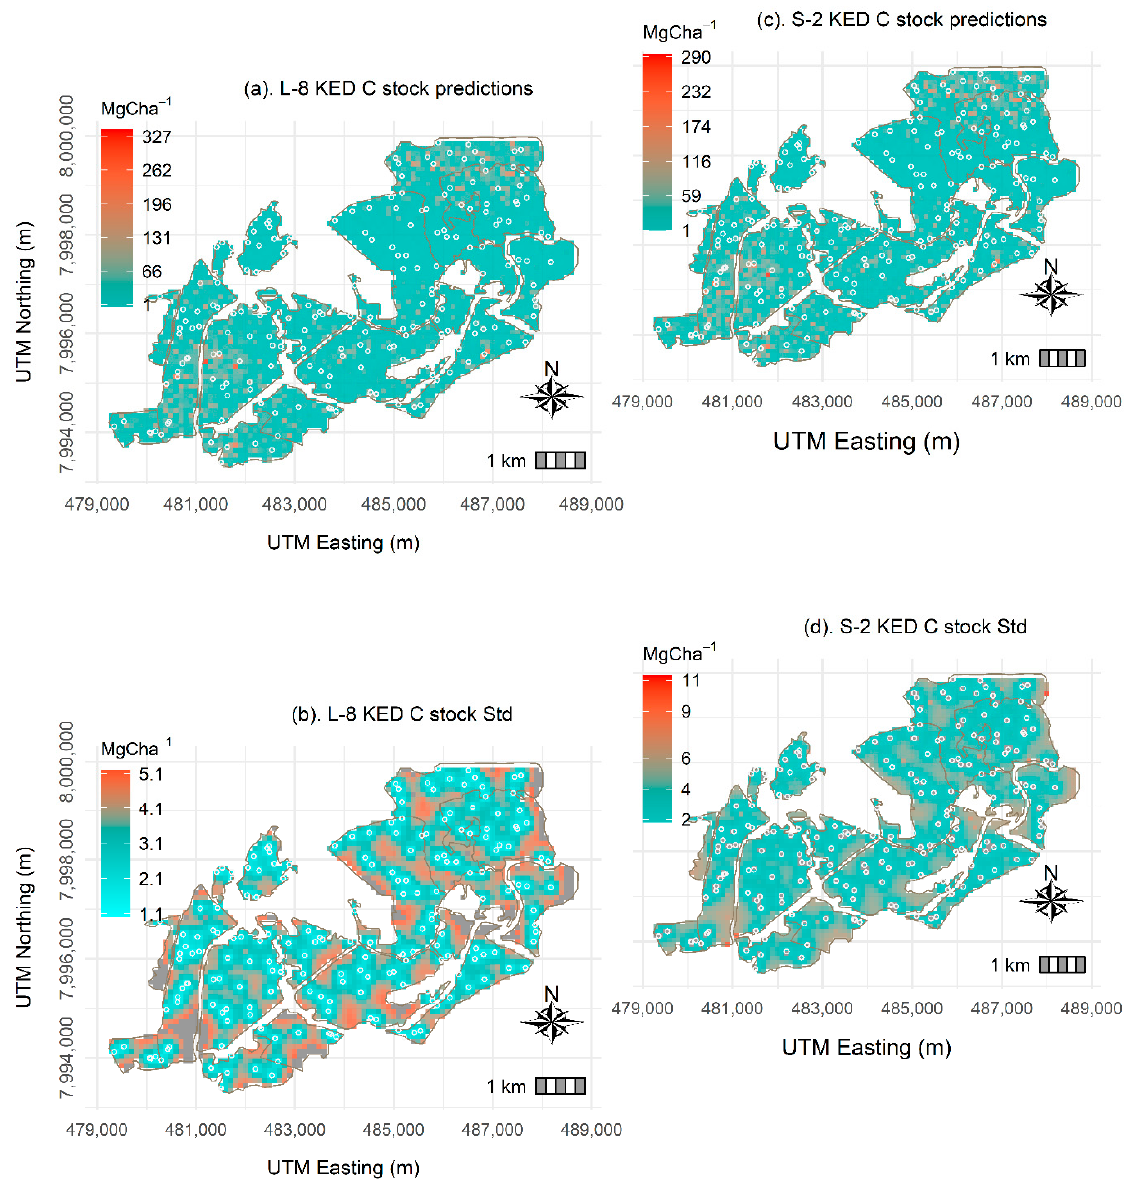
Figure 6: Frequentist Landsat-8- (L-8) and Sentinel-2 (S-2)-based C stock predictions and 95 % confidence intervals.